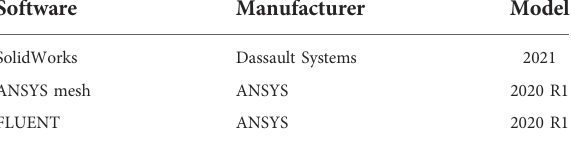
TABLE 2 Manufacturer and model of the main software.